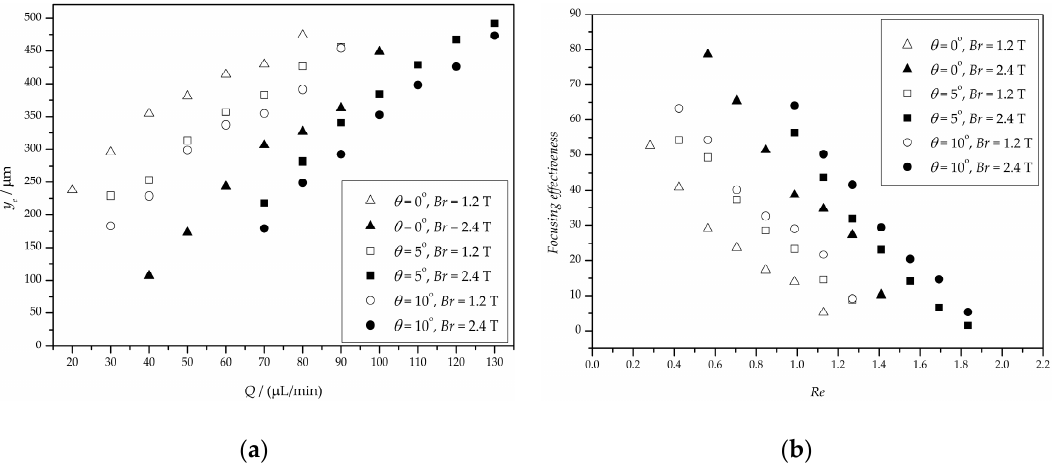
Figure 12. The results of focusing particles at different flow rates. ( a ) The width of the focused particle stream; ( b ) the focusing effectiveness.